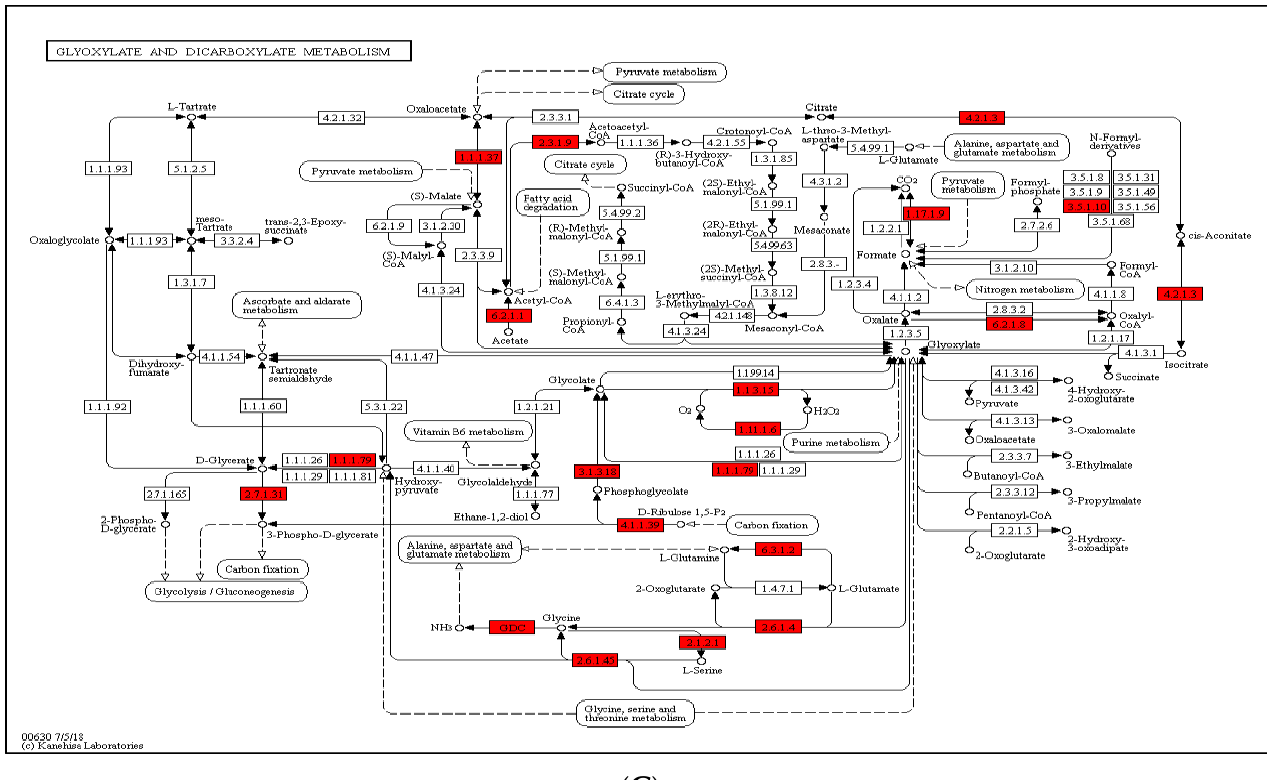
Figure 5 . ( A ) Crotonylated proteins involved in photosynthesis. The identified crotonylated proteins are highlighted in red. ( B ) Crotonylated proteins involved in carbon fixation in photosynthetic organisms. The identified crotonylated proteins are highlighted in red. ( C ) Crotonylated proteins involved in glyoxylate and dicarboxylate metabolism. The identified crotonylated proteins are highlighted in red.